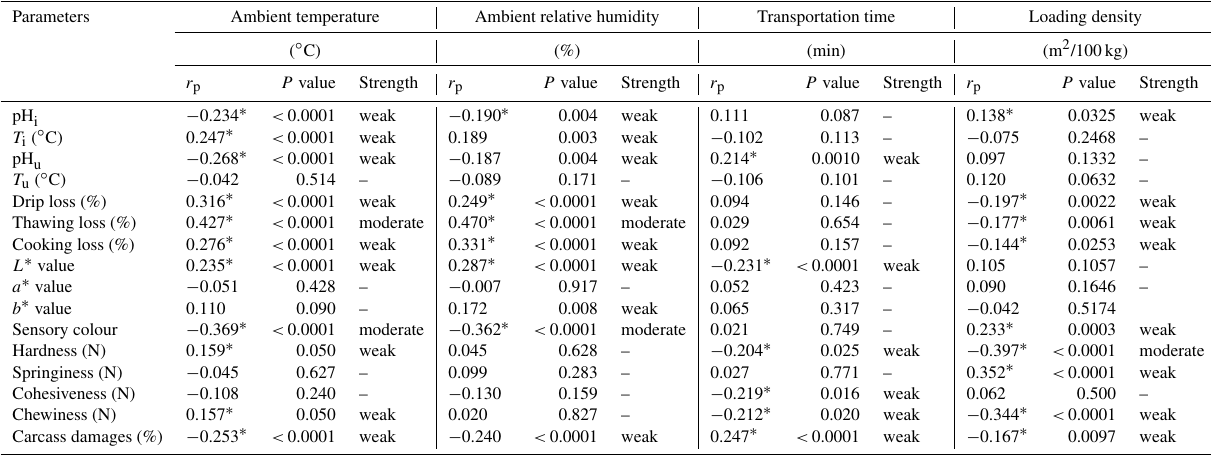
Table 4. Pearson correlations between weather conditions, transportation time and loading density and carcass damages and pork quality